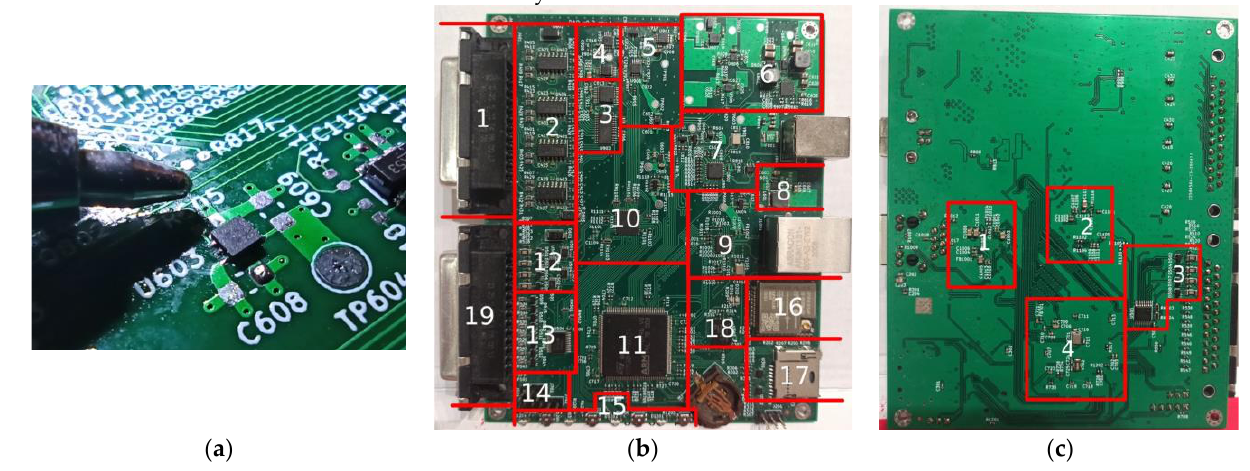
Figure 7. MIC94345 mounted on a PCB ( a ); PCB — top view ( b ); PCB — bottom view ( c ).